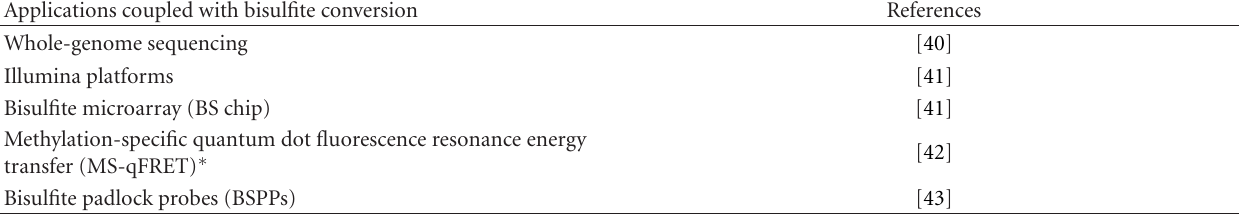
Table 2: Techniques for genome-wide analysis of the